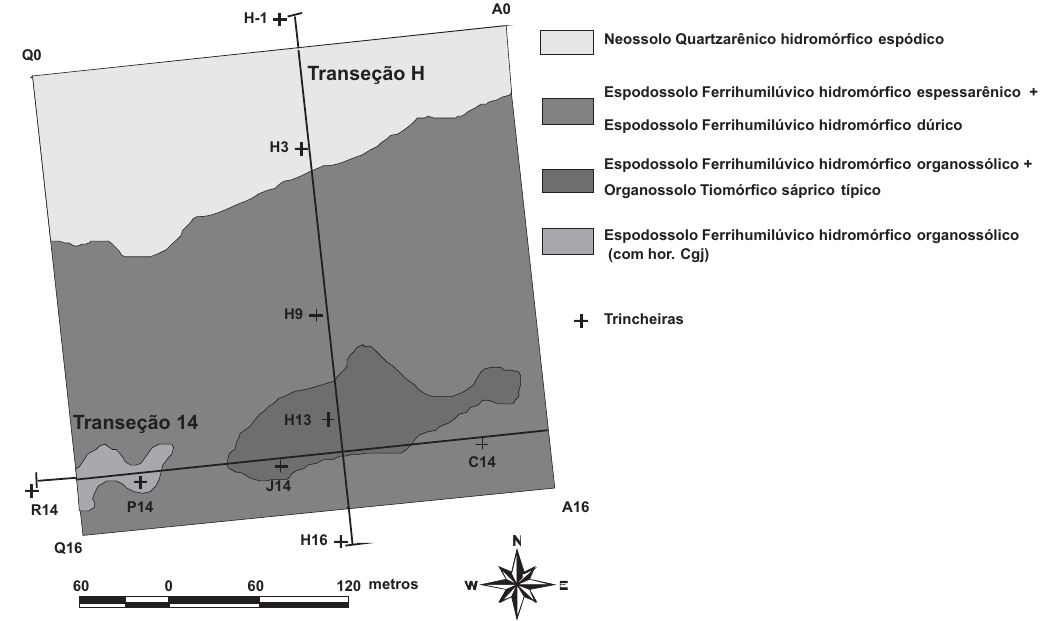
Figura 2. Mapa de solos indicando a localização das transeções e trincheiras